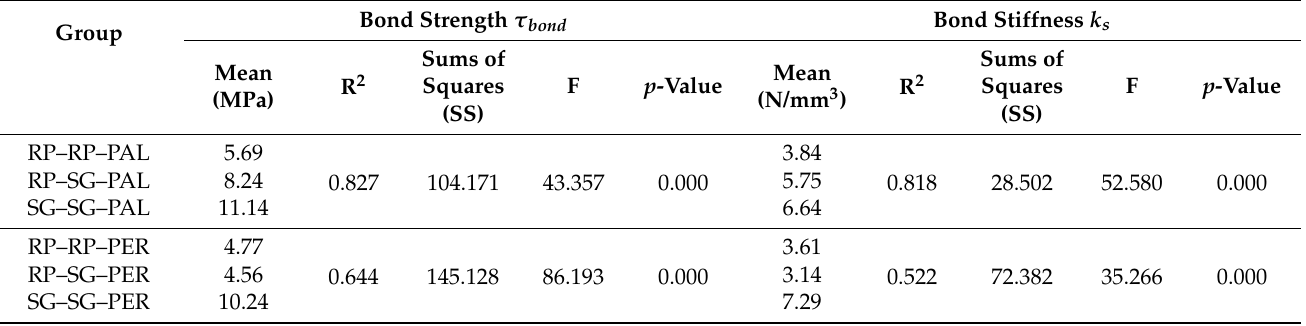
Table 5. Effects of species on shear bond strength and bond